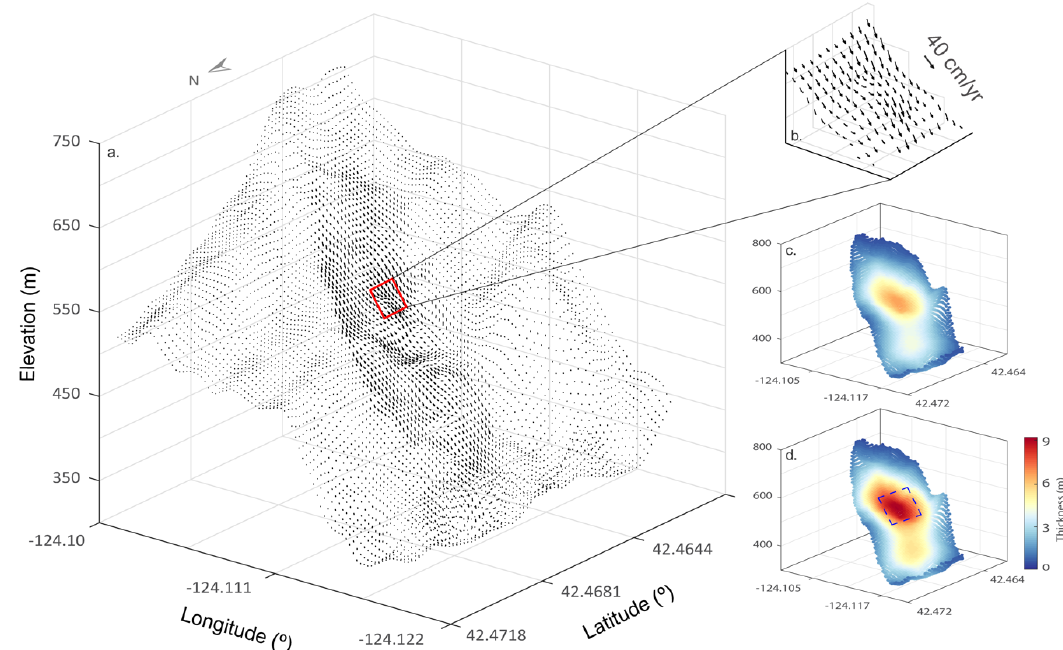
Figure 6. Surface velocity vector and thickness of the Lawson Creek landslide. ( a ) Surface velocity fields derived from InSAR LOS measurements and ( b ) a close-up of a typical fast-moving area. Thickness inversion results by setting ( c ) f = 1 and ( d ) f = 2/3 are shown with the same view angle as (a), and the non-landslide regions are manually masked out. The dashed blue square in (d) outlines the central region for calculating the average depth.